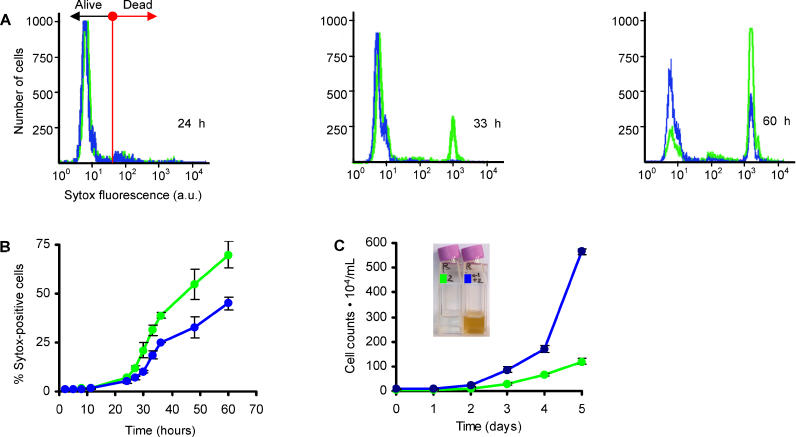
Sublethal DD Concentrations Can Induce Resistance to Lethal Doses in P. tricornutum
Cells were pretreated with 0.1 μg/ml (660 nM) DD for 2 h prior to subsequent addition of 2 μg/ml (13.2 μM) DD (blue) and compared to a single dose treatment of 2 μg/ml (13.2 μM) DD (green).(A and B) Cell death was assayed by flow cytometry both qualitatively in cytograms (A) and quantitatively (B) using Sytox Green at the indicated time points.(C) Cell growth curves following resuspension of pretreated and non-pretreated cells in DD-free fresh medium 60 h after the 2 μg/ml (13.2 μM) DD treatment. The time scale indicates the days following resuspension. Inset shows photograph of the two cultures taken 2 wk after resuspension starting from an initial inoculum of 5 × 104 cells/ml.Representative data from at least five experiments are shown in (A–C).a.u., arbitrary units.